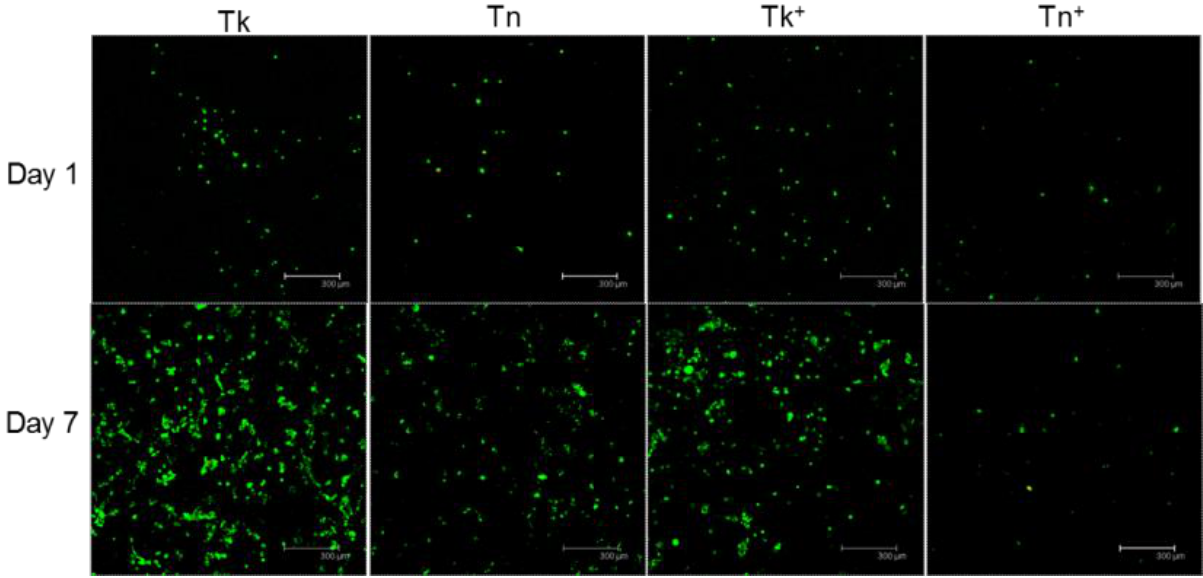
Figure 9. The Live/Dead staining of fibroblasts on CSNFMs by calcein AM and propidium iodide for live (green) and dead (red) cells after cultured for one and seven days and observed by confocal laser scanning microscopy. Bar = 300 μm.